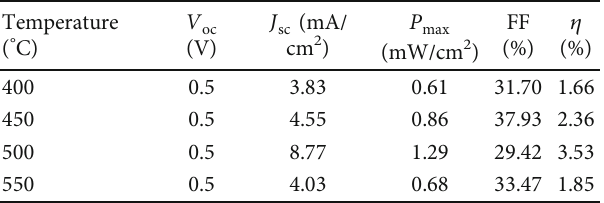
Figure 9: J - V characteristic curve of DSSC using Mg-doped ZnO as photoanode at di ff erent annealing temperatures. Table 3: Summary of electrical properties including open-circuit voltage, short-circuit current, fi ll factor, and e ffi ciency of DSSC for di ff erent annealing